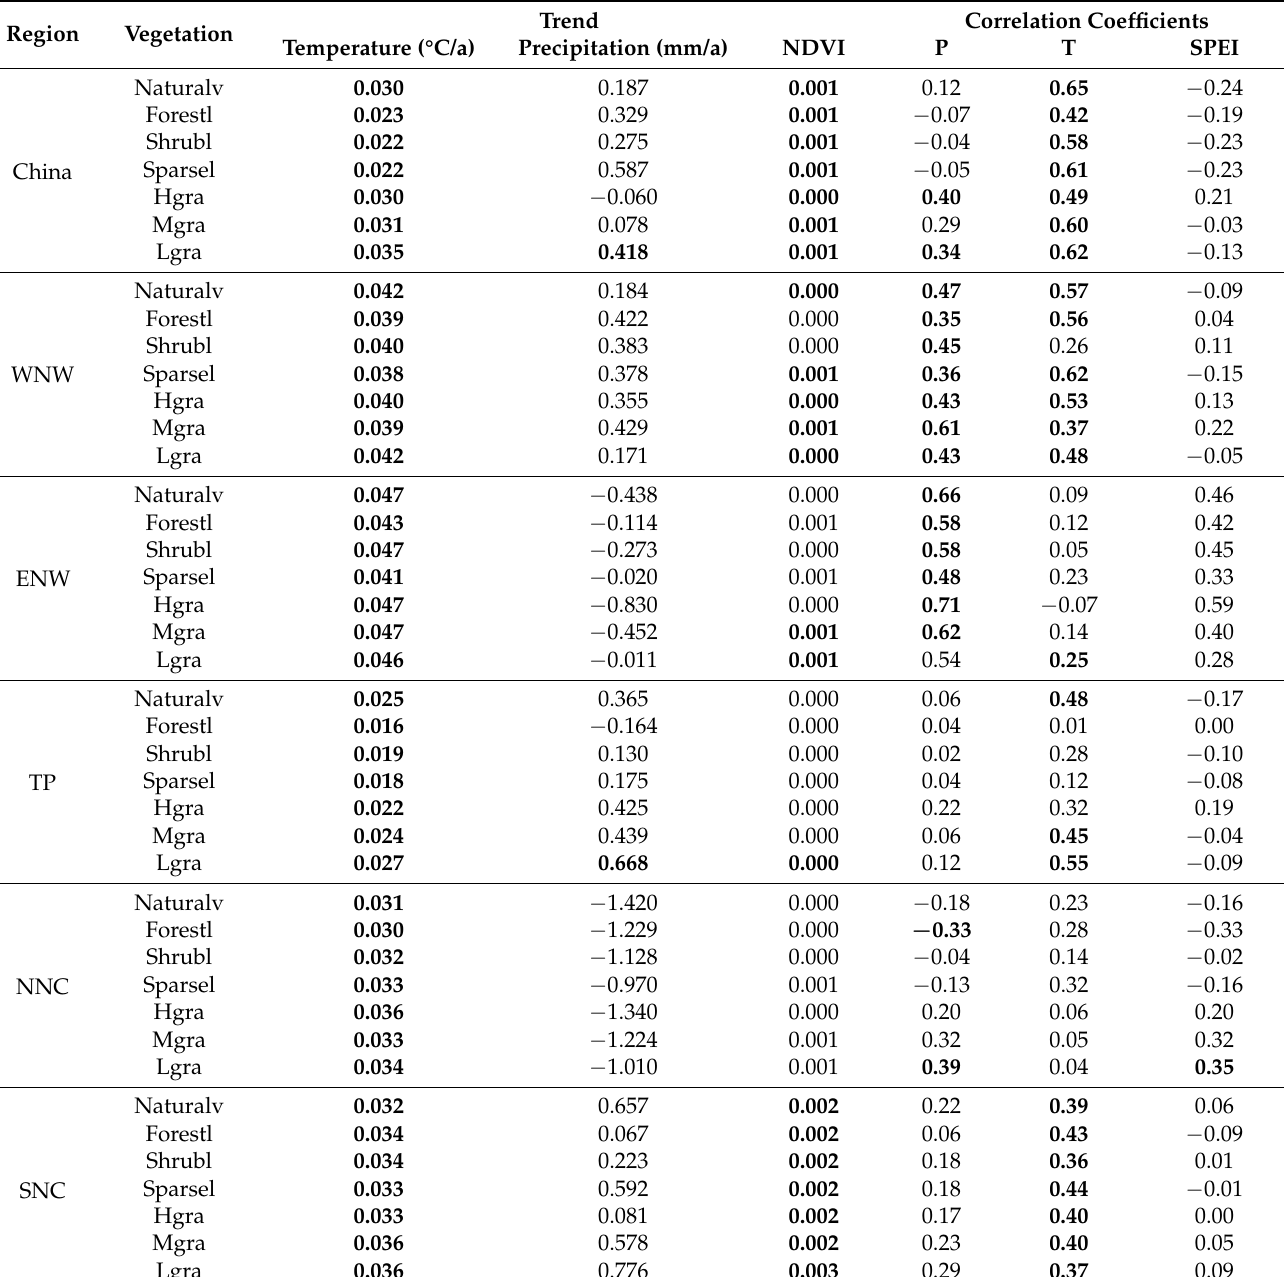
Table 3. Regional changes to the Normalized Difference Vegetation Index (NDVI) in China and the correlations between the NDVI and precipitation and between the NDVI and temperature during the growing season (significant trends and correlations at the 0.05 significant level are indicated in